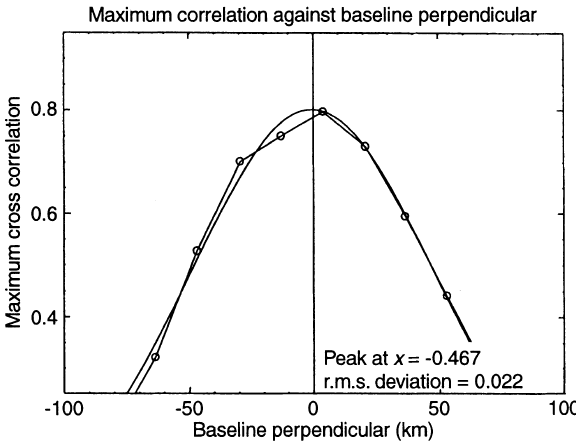
Fig. 2. The maximum correlation coe(cid:129)cient for di(cid:128)erent values of b the perpendicular baseline. Each point represents the analysis of 10 min observation. The Gaussian curve fitted to these points has a peak value for b (cid:24) 0.5 km and the standard error in each point (cid:114) (cid:94) (after allowing for the loss of 3 degrees of freedom in